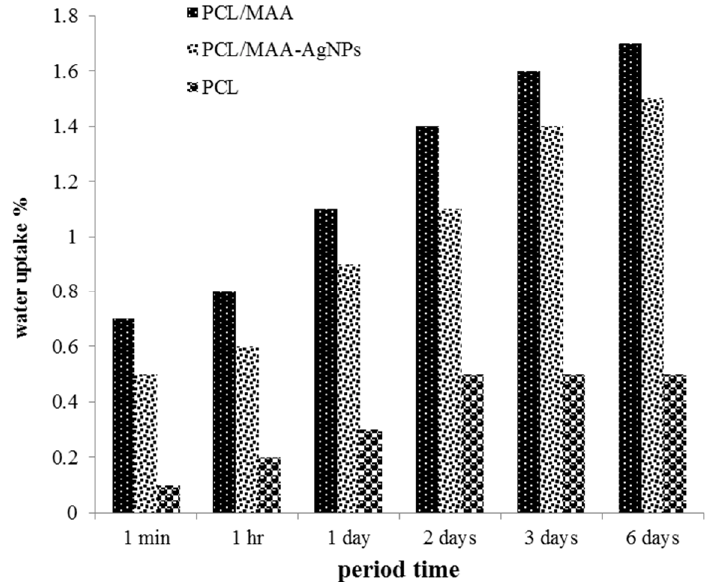
Figure 4. Water uptake (%) of electronspun PLC/MAA graft copolymer, PCL/MAA-AgNPs and PCL nanofibers.